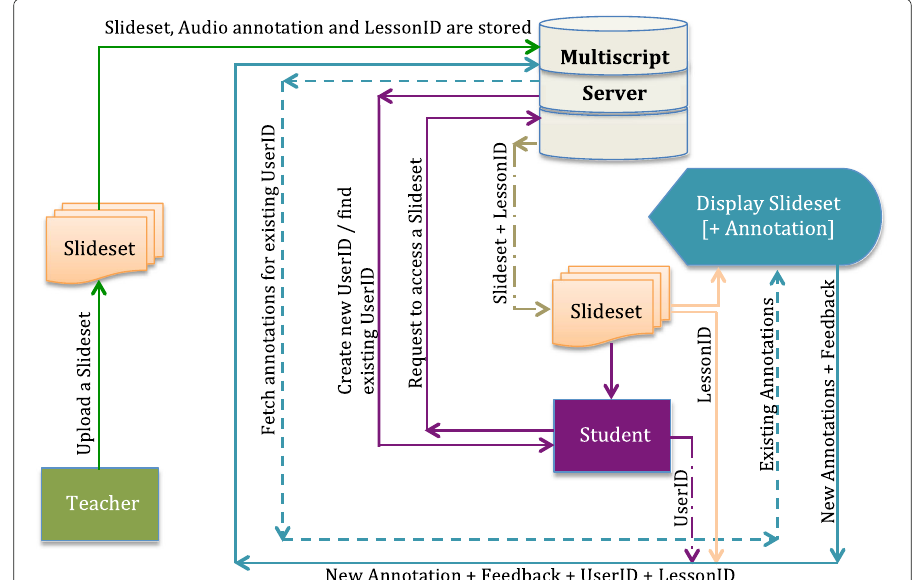
Fig. 3 Data flow within the Multiscript platform